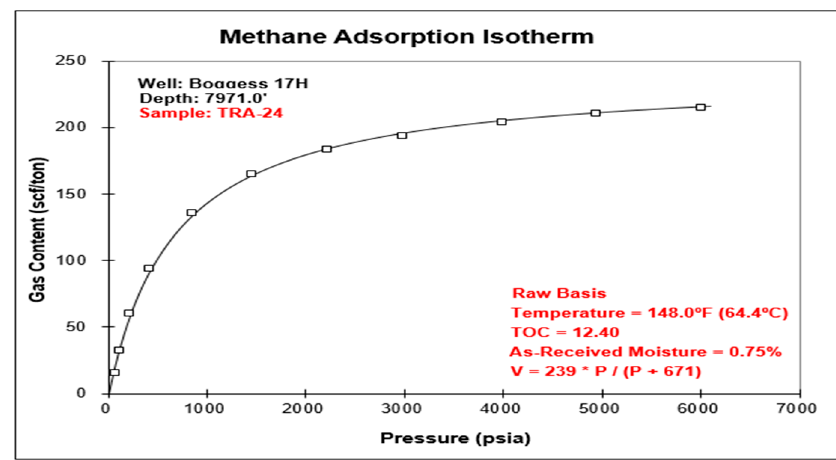
Figure 3. Methane adsorption measurements. Table 1. Summary of Langmuir adsorption parameters courtesy of Schlumberger Reservoir Labor-